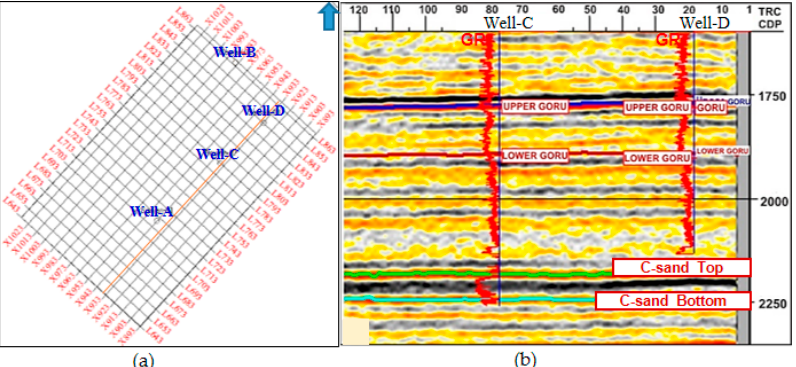
Figure 2. ( a ) Seismic base map with wells and Xline 932 (orange color), ( b ) Seismic to well tie at Xline